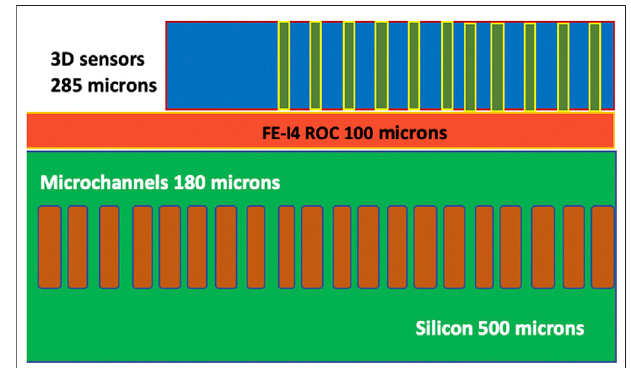
FIGURE 1 | Sketch of the vertically integrated 3D system with 285-µm- thick double-sided partially through 3D sensors (top) , 100-µm-thick FE-I4A ATLAS pixel readout electronics (middle) , and 500-µm-thick silicon-etched microchannels for thermal management (bottom) . The distance from the microchannels to the electronic chip is 120 µm; the channels ’ depth is 180 µm.Thetotalthicknessofthesystemincludingthesensorandelectronics is 885